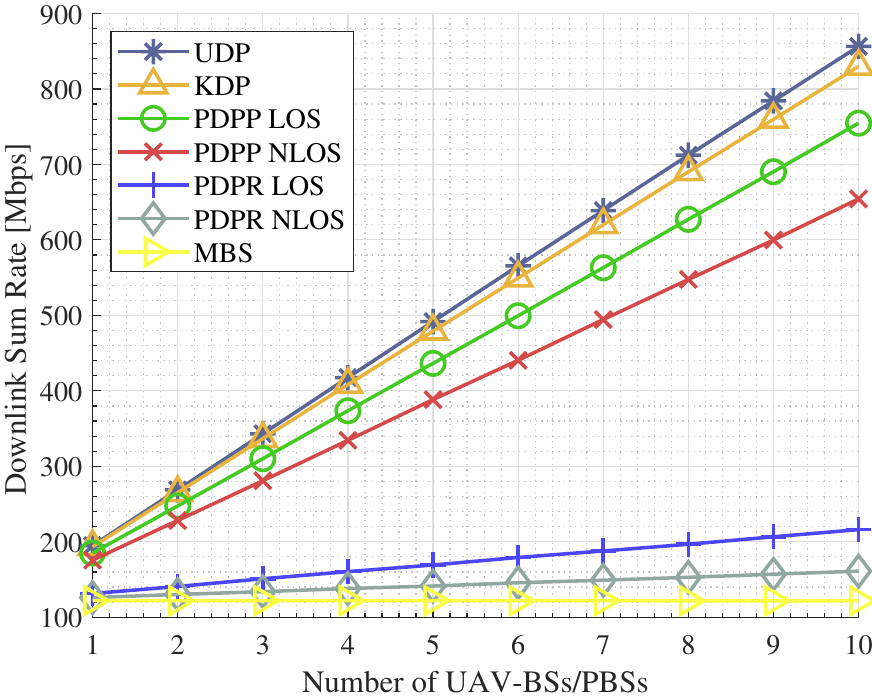
Figure 6. Downlink system sum rate for different number of